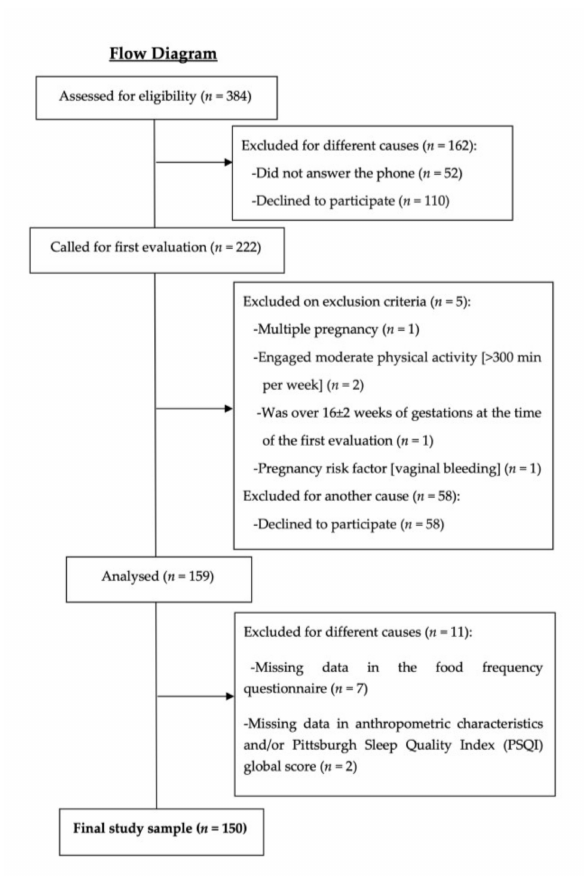
Figure 1. Flow diagram of the study